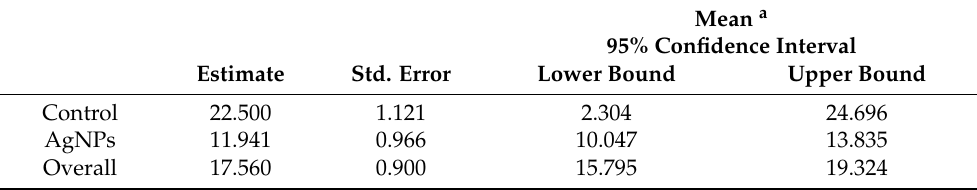
Table 10. Mean survival time (Groups 2a and 2b).